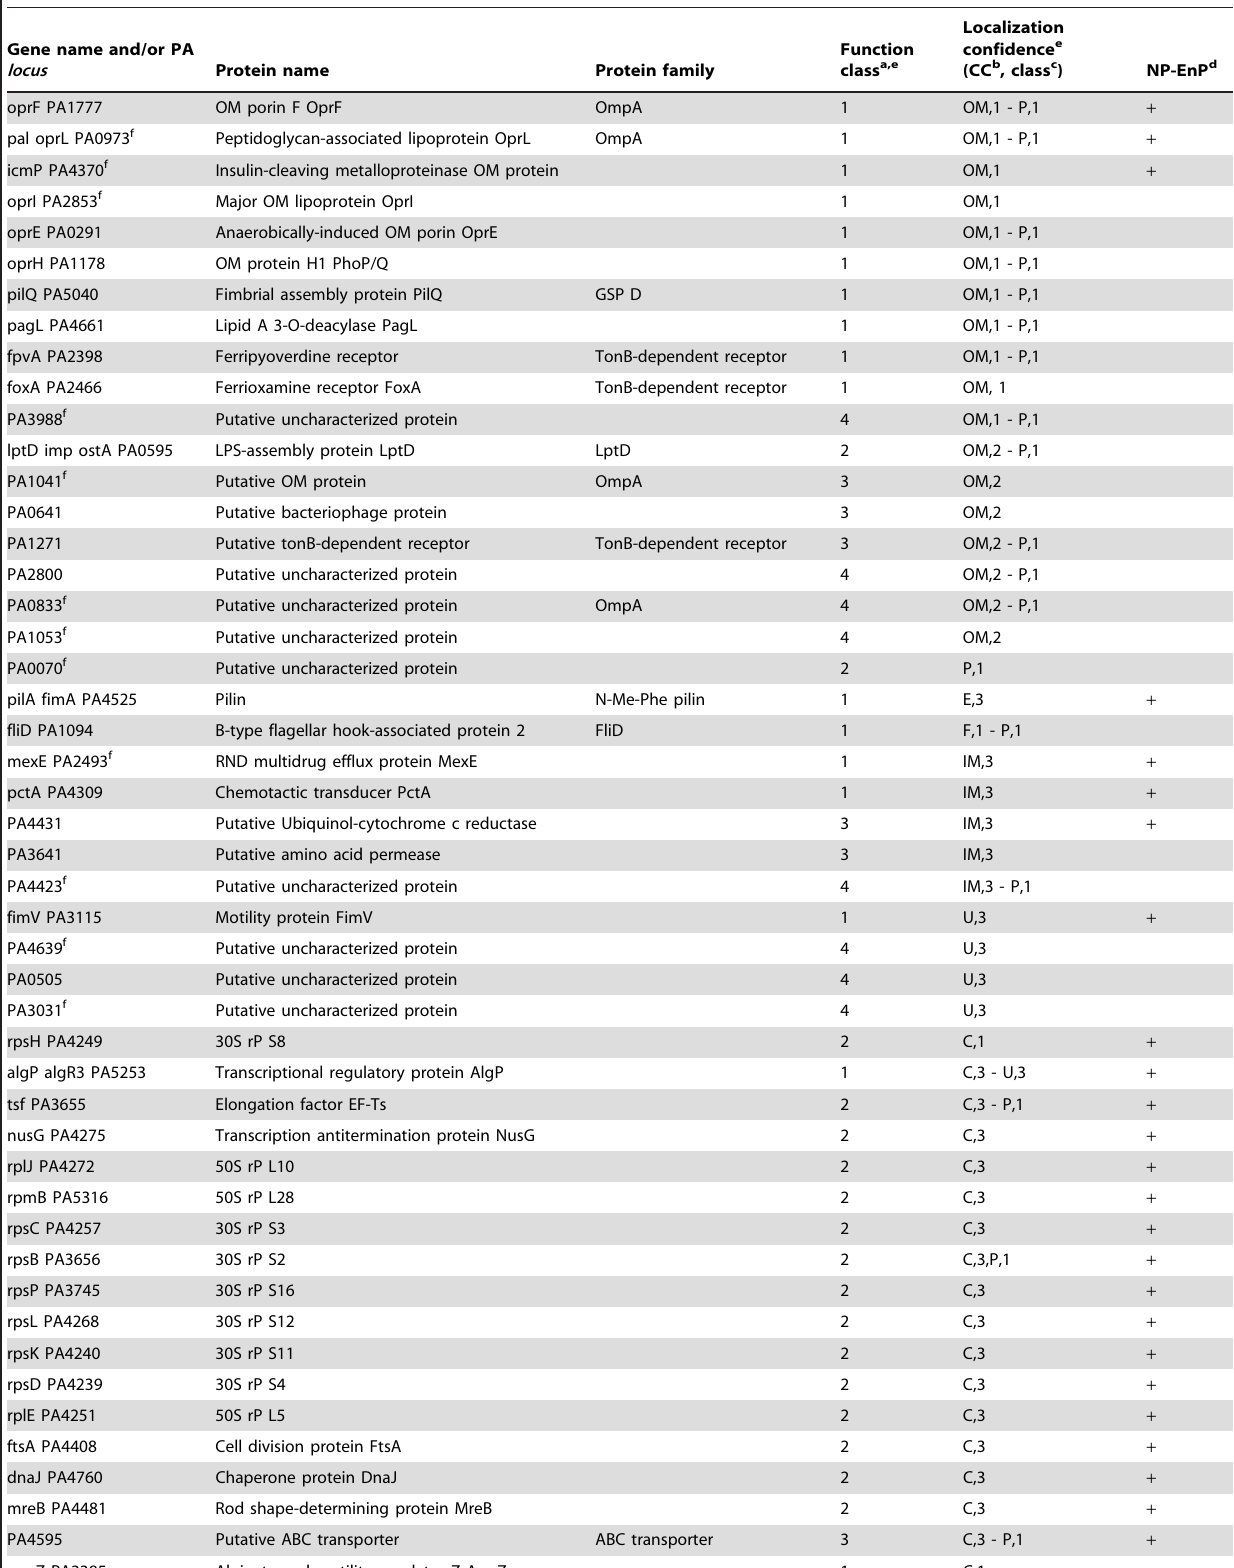
Table 1. List of envelope-associated proteins covalently bound by NPs at cell surface (NP-CbP).